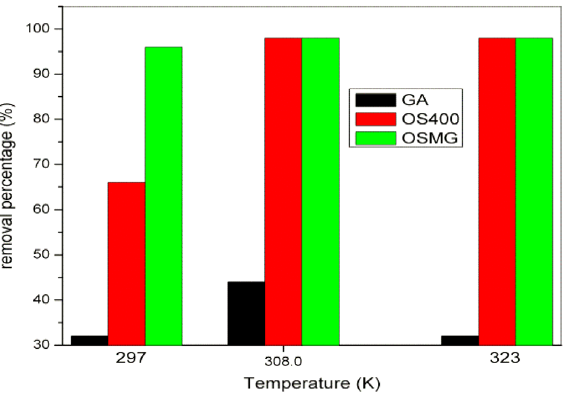
Figure 8. Effect of different temperatures on the removal percentage of MB adsorbed onto GA, OS400 and